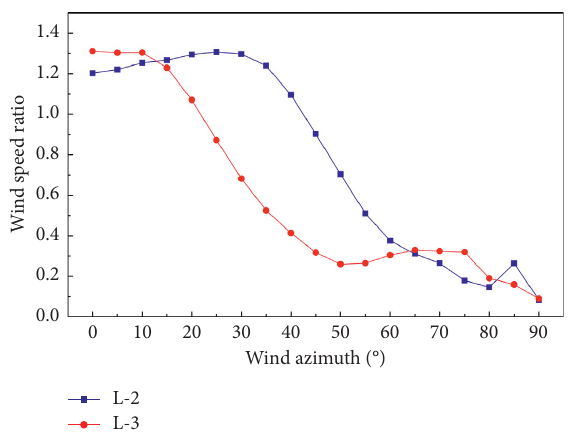
Figure 23: The variation of the wind speed ratio in the models of L- 2 and L-3 with the wind direction.